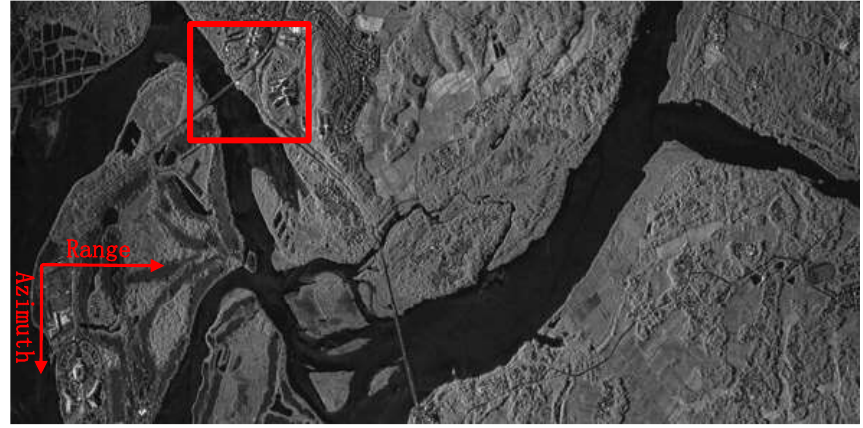
Figure 7. Second processed sliding spotlight SAR image via the proposed approach.